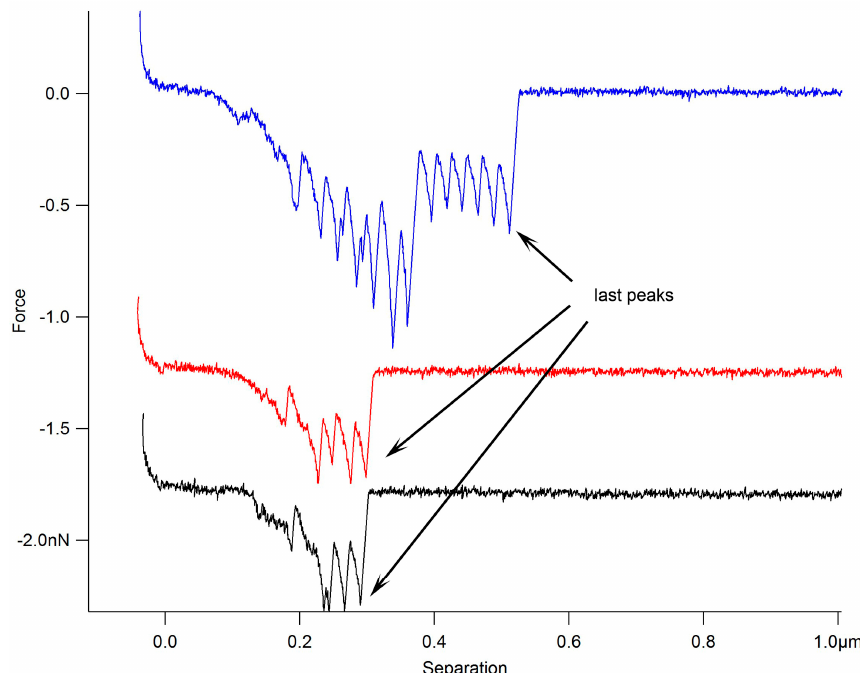
Figure 1. Example of retraction force-distance curves of mucus-binding protein (MUB) unfolding. Typical force-distance curves were obtained when probing the interaction between MUB and pPGM in phosphate buffered saline (PBS) ( blue curve ) α 2,6-sialyllactose (6’SL) (100 mM, red curve ) and a mixture of 3’SL (50 mM) and 6’SL (50 mM) ( black curve ). The red and black curves are offset for clarity. The symmetrical nature of the negative peaks suggests that MUB is unfolding. The “last peaks” are the “rupture” events of MUB’s interaction with pPGM. The effect of the free sugars on the interaction between MUB and pPGM suggests that the binding is mediated by protein–carbohydrate interactions with terminal mucin glycans.